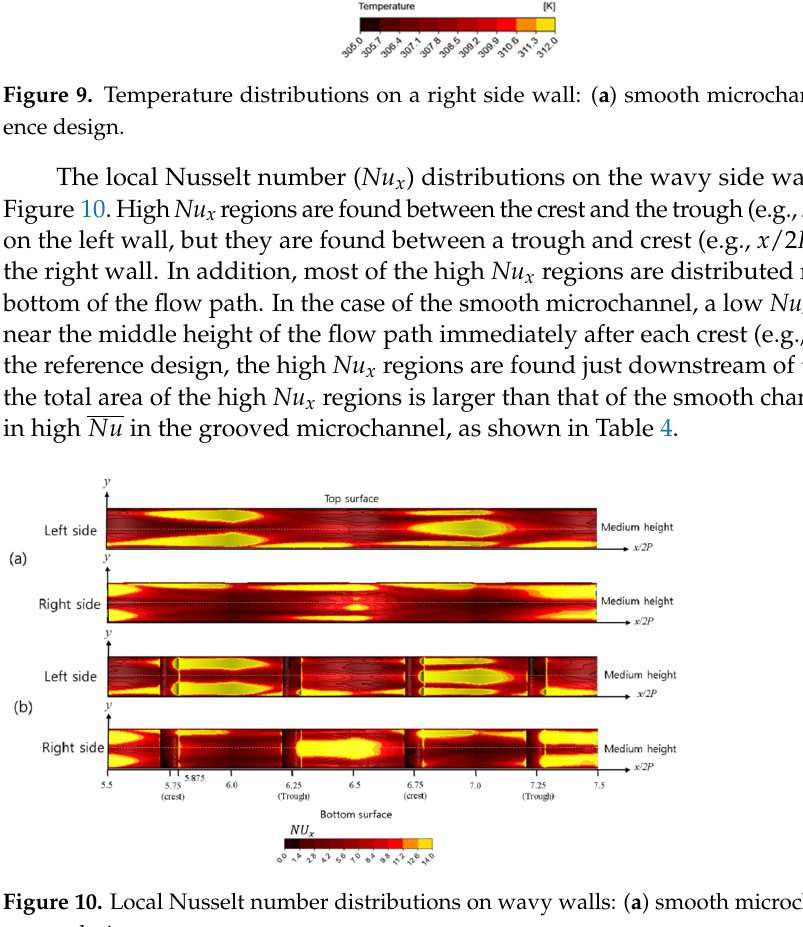
Figure 10. Local Nusselt number distributions on wavy walls: ( a ) smooth microchannel and ( b ) reference design.